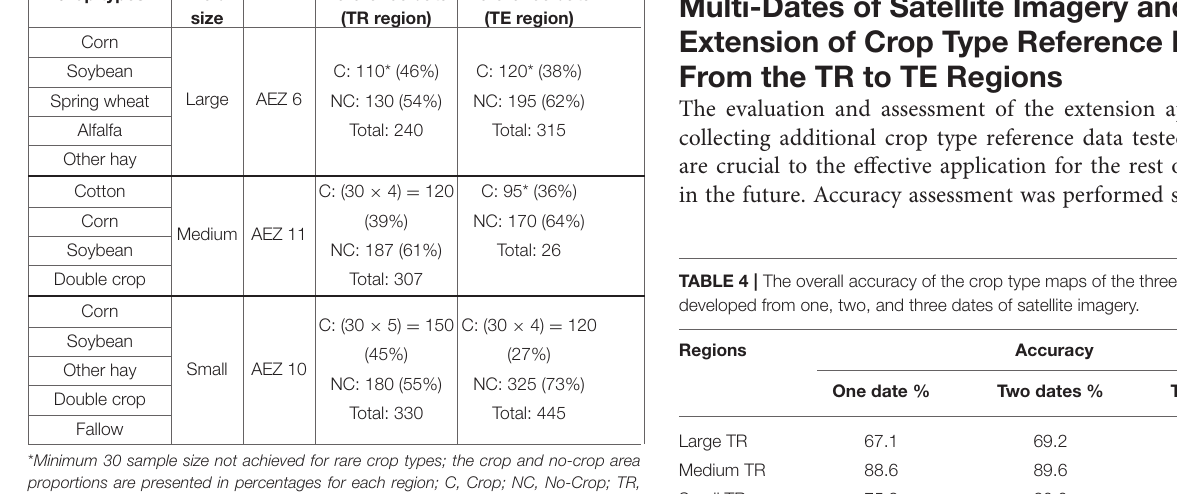
TABLE 2 | The reference data used to assess the crop/no-crop and crop type maps of the three TR and three TE regions. Crop types